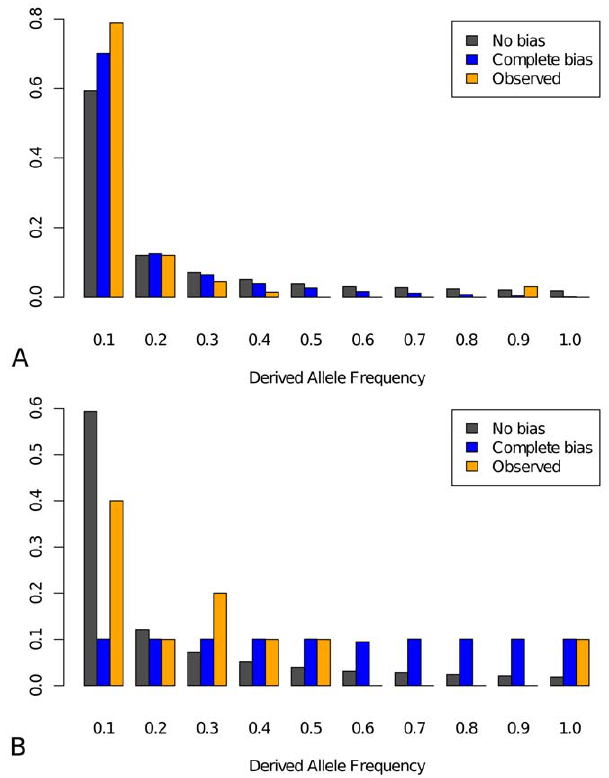
Figure 4. Site frequency spectra. (A) Affinity-decreasing mutations and (B) affinity-increasing mutations. Grey: neutral expectation with no ascertainment ( f ~ 0 ); Blue: neutral expectation under complete ascertainment ( f ~ 1 ); Orange: observed frequency spectrum. The calculations of the expected frequency spectrum under no bias and complete bias are described in supplementary methods. The total number of segregating sites for affinity-decreasing and affinity- increasing mutations is 64 and 15,